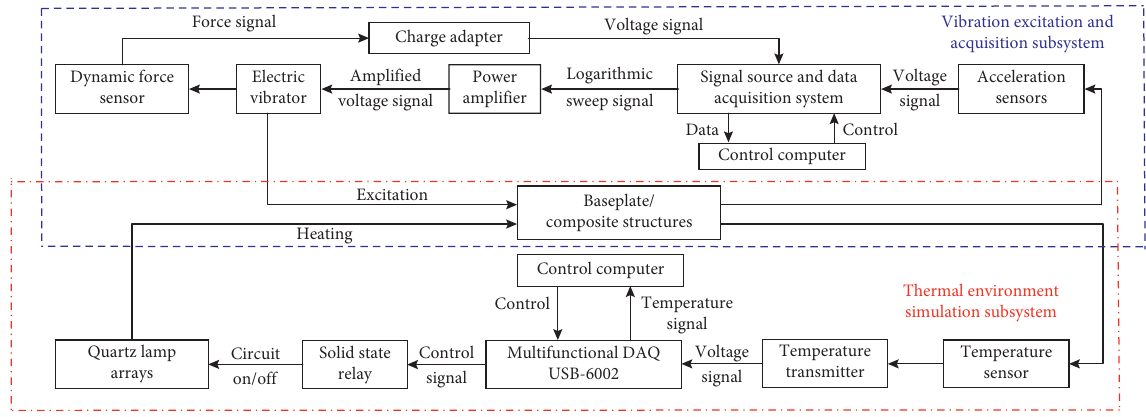
Figure 8: Block diagram of the thermal-vibration joint test